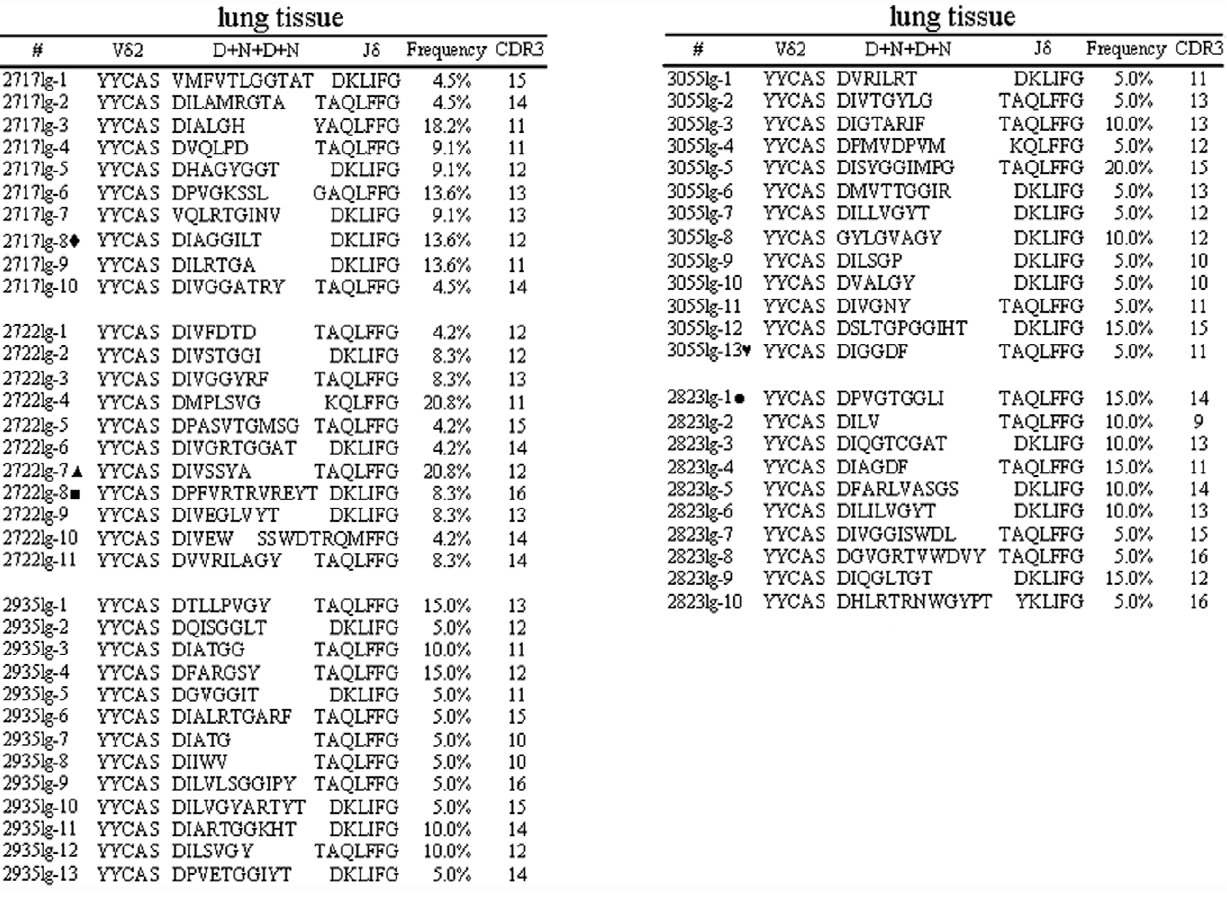
Figure 2. Polyclonally-expanded V c 2V d 2 T cells from lymphoid tissues appeared to distribute and localize in lung TB granuloms after Mtb infection by aerosol. Shown are individual V d 2 TCR clones isolated from lymphocytes of lung tissues from five Mtb-infected macaques. The immunohistochenistry data showing infiltration and distribution of V c 2V d 2 T cells in TB granulomas were shown in the previous publication [18]. Flow cytometry data indicating cellular expansion of V c 2V d 2 T cells in CD3 + T cells isolated from the lung tissues were described in the text. Note polyclonal V d 2 TCR sequences and sub-dominant clones in cDNA derived from lung lymphocytes in which expansion of V c 2V d 2 T cells was detected. Clones present in blood and spleen were marked as described in the legend of Fig. 1.